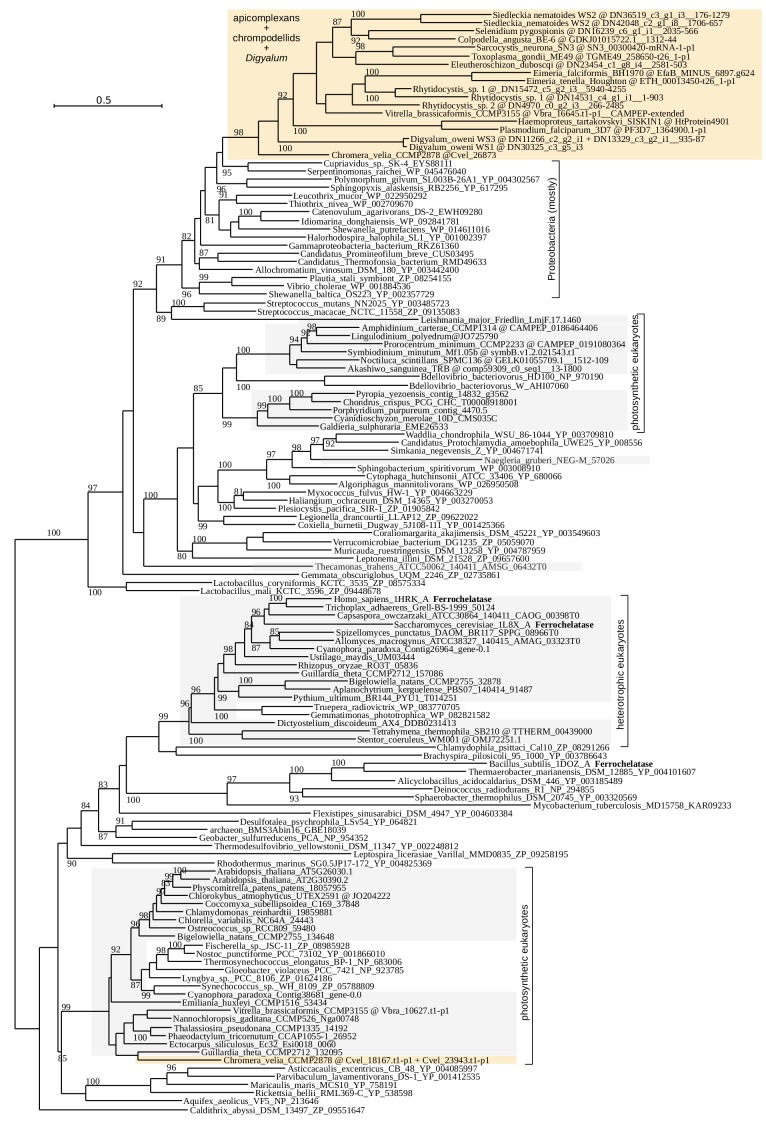
Maximum likelihood phylogeny of the ferrochelatase, HemH (LG+R8 model in IQ-TREE with 10000 UFBoot2 replicates;≥80 are shown).Apicomplexans, chrompodellids and Digyalum are shown on orange background and other eukaryotes on gray background. Selected characterized enzymes are highlighted in bold.